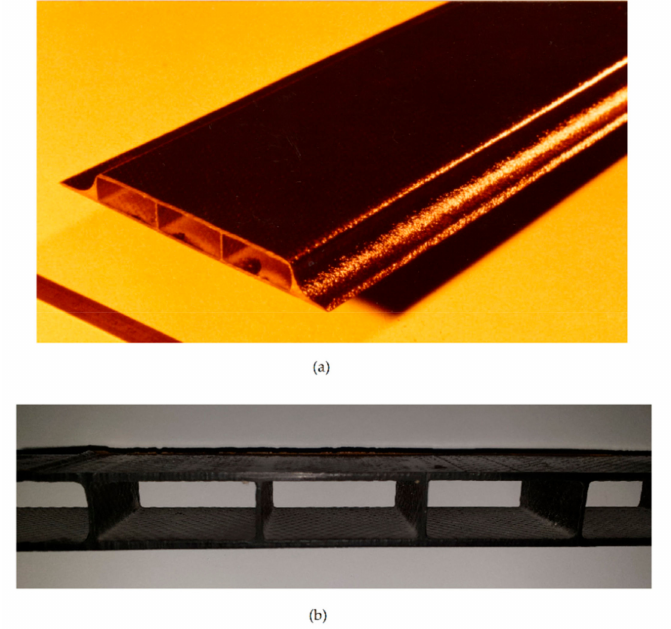
Figure 2. Aeronautical cellular structures: ( a ) Cellular beam and ( b ) Rectangular cellular panel. Panel thicknesses: top and bottom skin 2 mm, cell width 33 mm, cell height 12 mm, and side walls 1